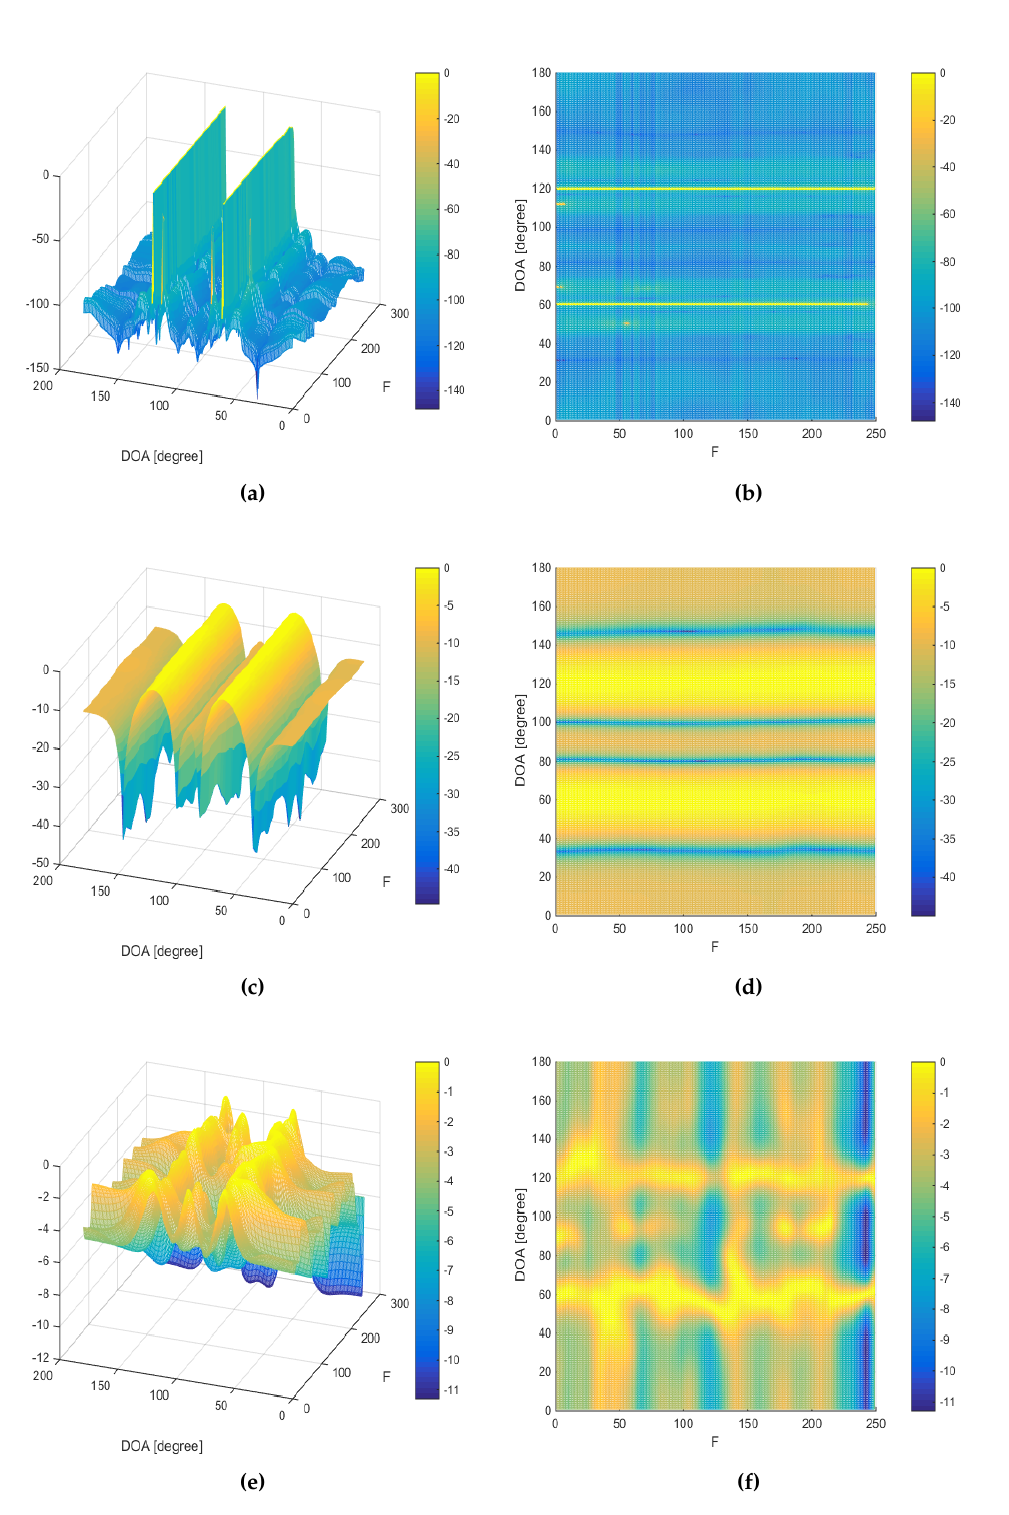
Figure 20. Wideband DOA estimation, two chirp source signals at DOAs 60 ◦ and 120 ◦ , γ = 0.5, 10 snapshots, using uniform linear array (ULA) containing six sensors for conventional beamforming and the MUSIC